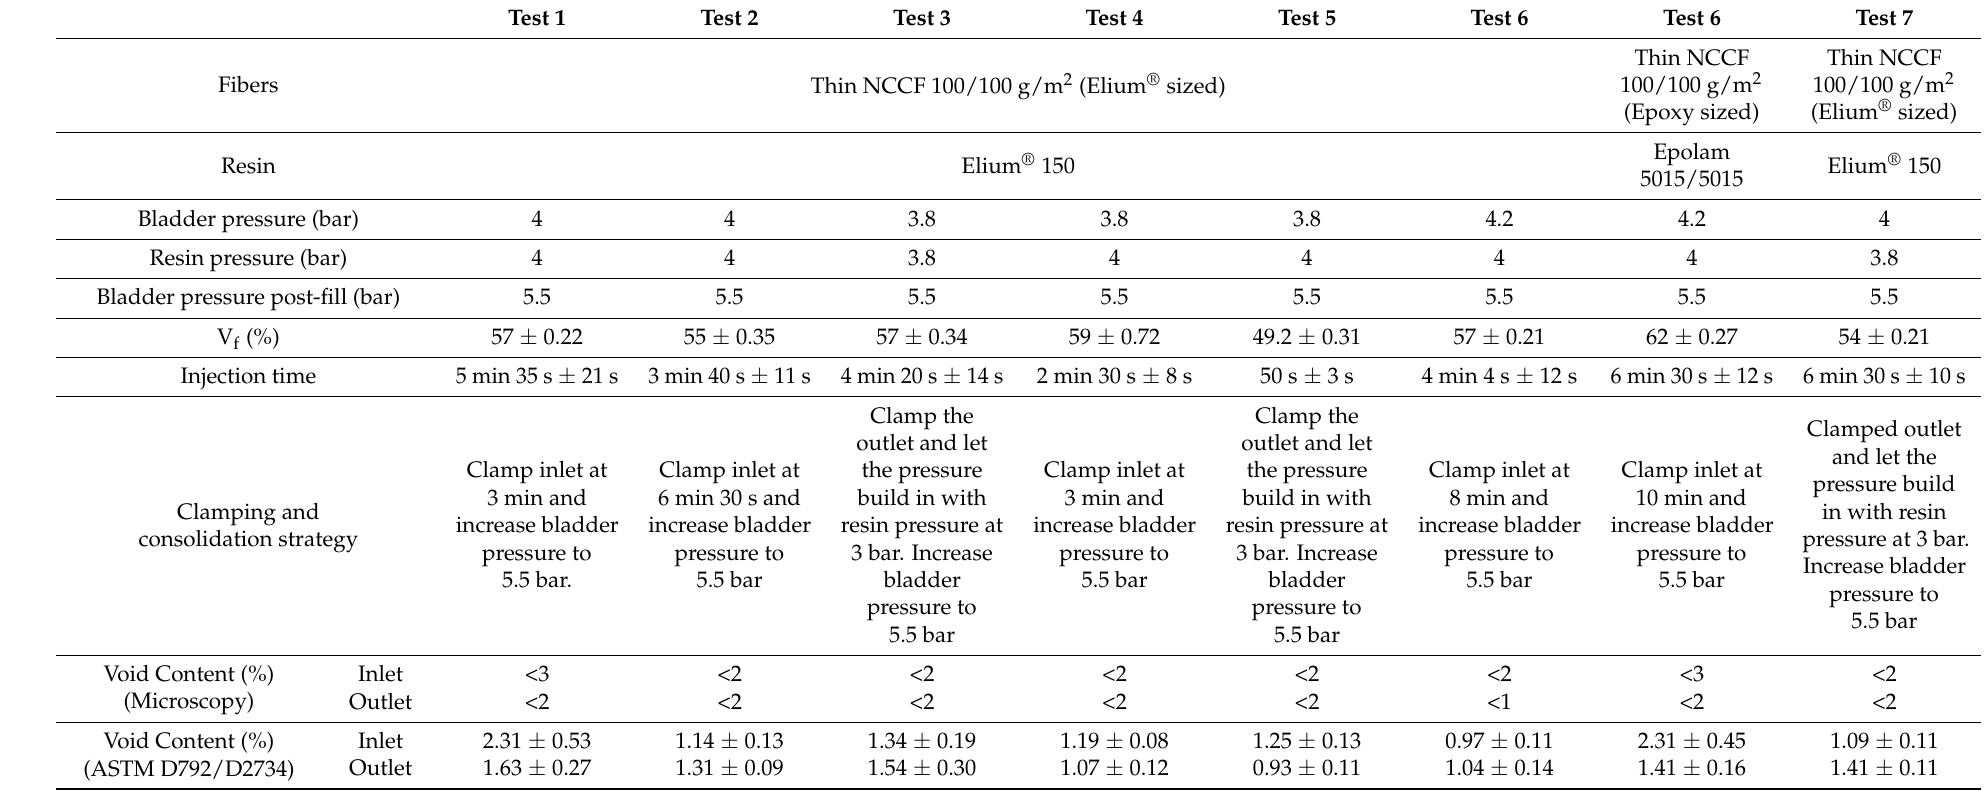
Table 4. Results from the process parameter optimization for various test cases for manufacturing a tubular